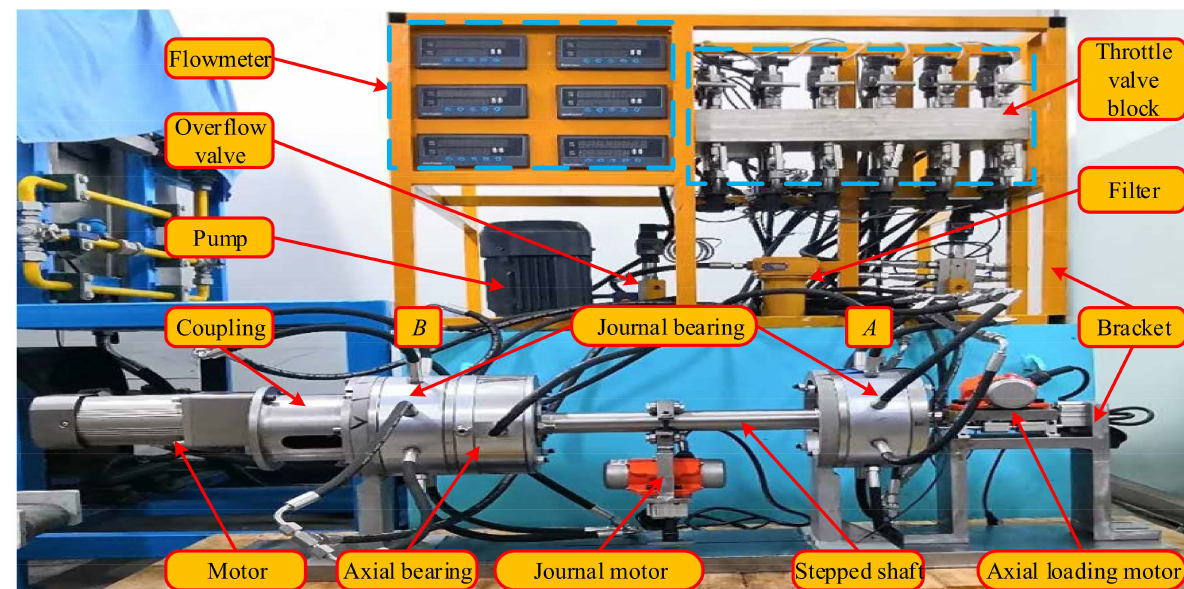
Figure 1. Overall drawing of MLDSB test bench.